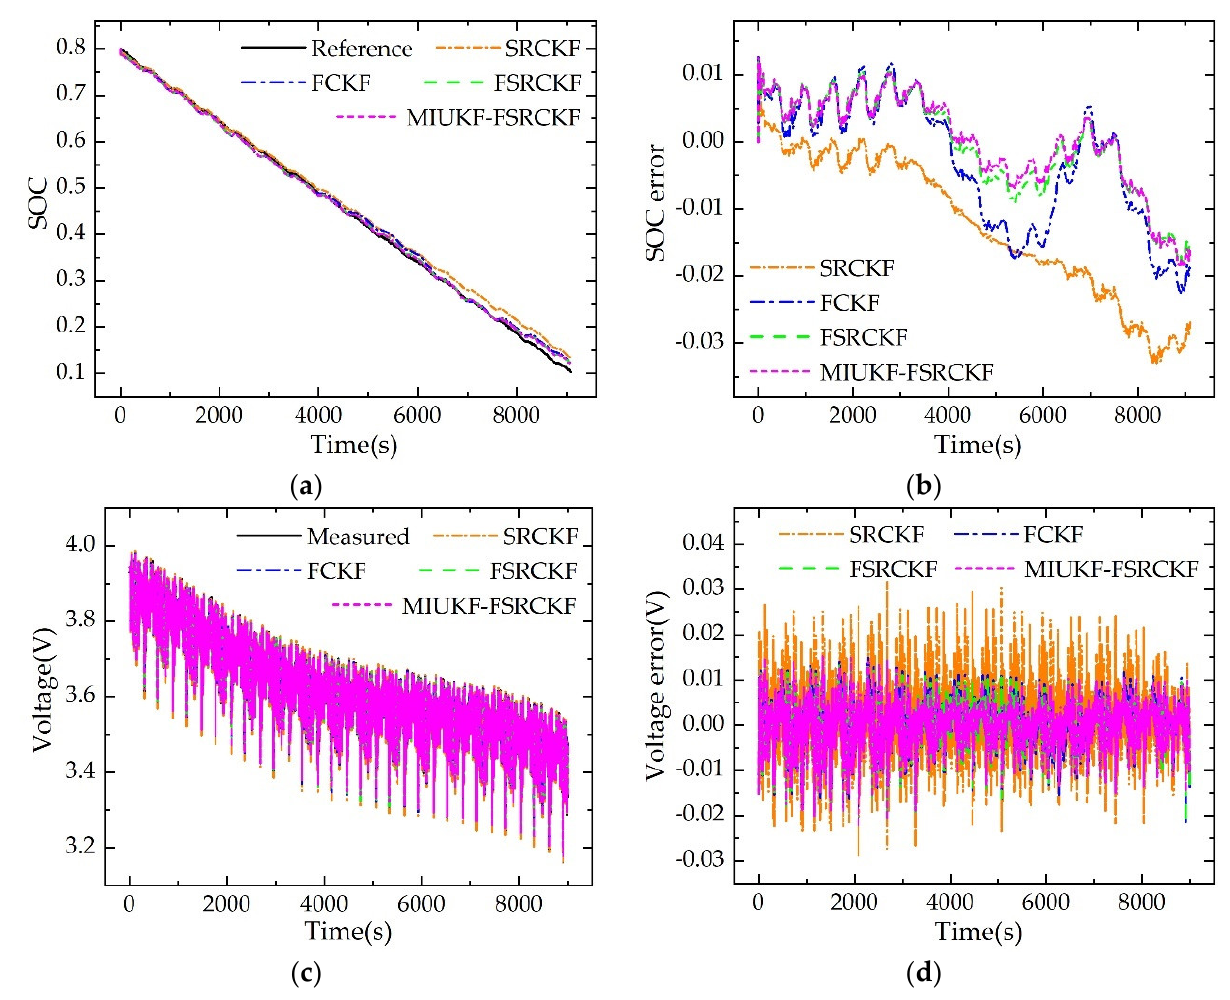
Figure 8. Comparison of the results of the four algorithms under US06 test: ( a ) SOC estimation result; ( b ) SOC error; ( c ) voltage estimation result; ( d ) voltage error.